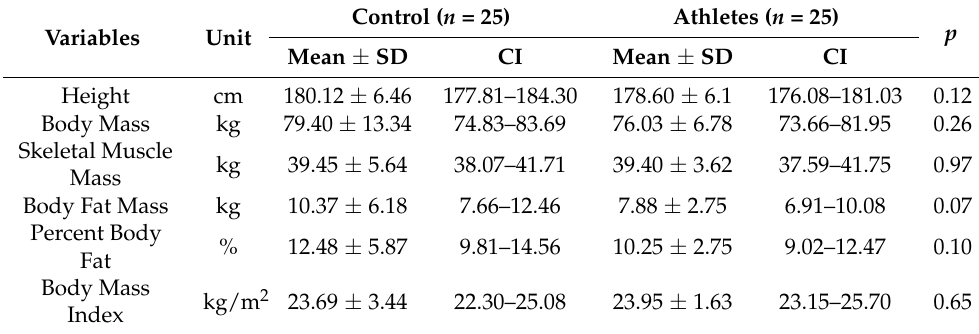
Table 1. Physical characteristics of the participants ( n =